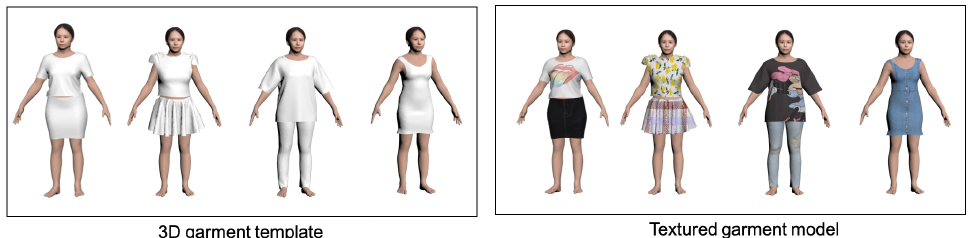
Figure 4. Some 3D garment model templates provided to users ( left ). Some textured 3D garment models ( right ).